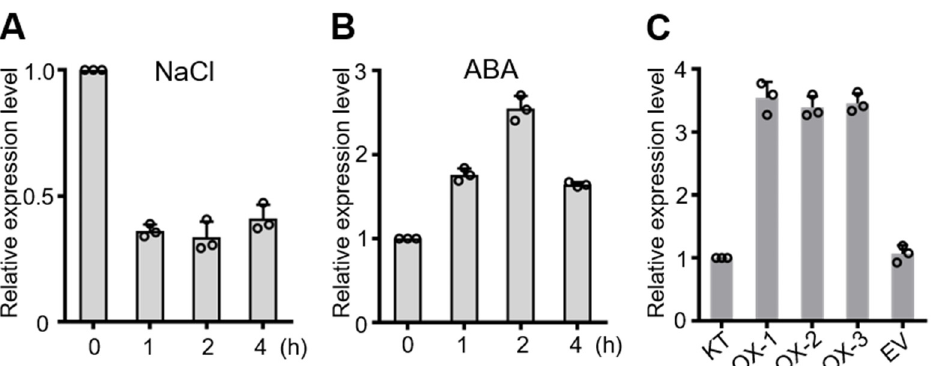
Figure 1. Expression patterns of OsWRKY50. ( A , B ) Transcript level of OsWRKY50 under salt stress ( A ) or ABA treatment ( B ) at 0, 1, 2, and 4 h. ( C ) Gene expression of OsWRKY50 in KT, overexpression lines, and EV plants. Ubiquitin was used as an internal control. Error bars indicate ± SD ( n = 3).